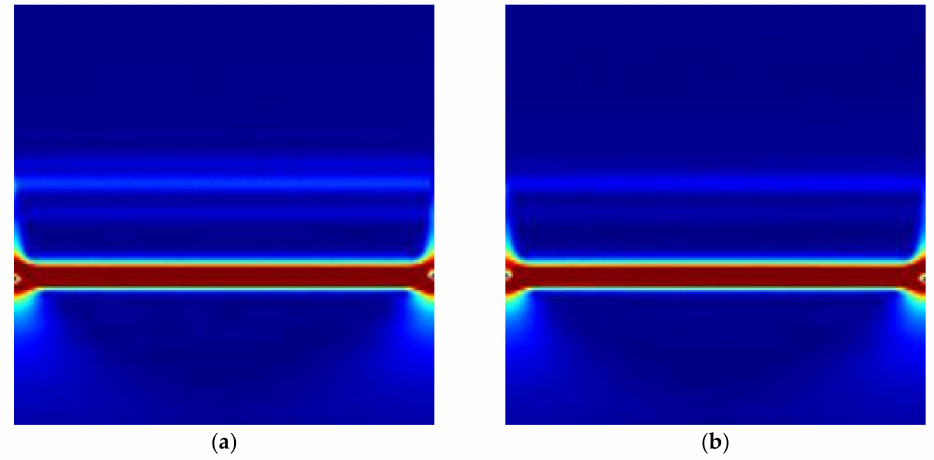
Figure 16. Scalogram images obtained with decimated data of the current signal: ( a ) single fault condition H6 and ( b ) double fault condition (H6 and